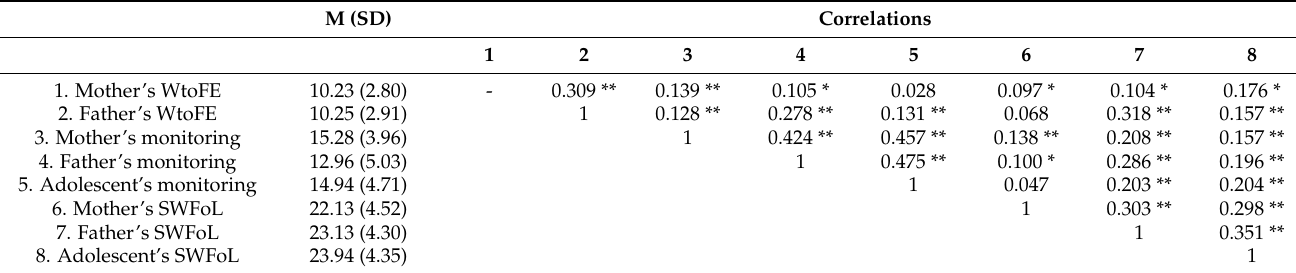
Table 2. Descriptive statistics and correlations for parent’s work-to-family enrichment (WtoFE), both